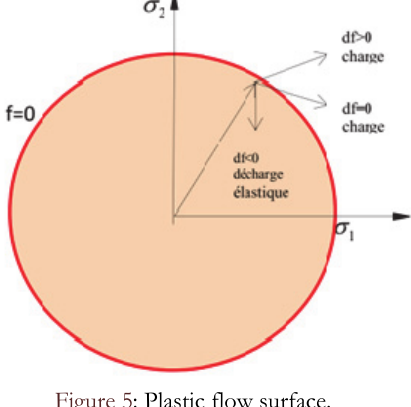
Figure 5: Plastic flow